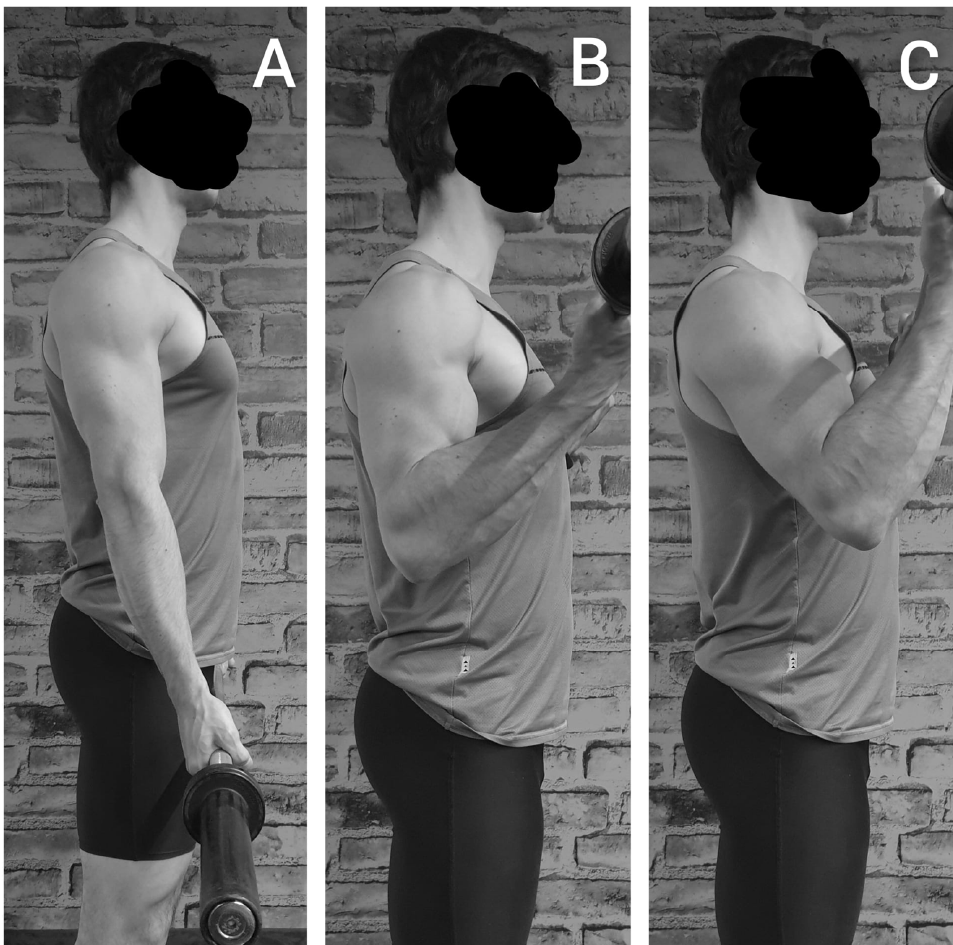
Figure 3. For both the straight and the EZ barbell, the start of the movement ( A ) and the end of the movement without ( B ) or with arm flexion ( C